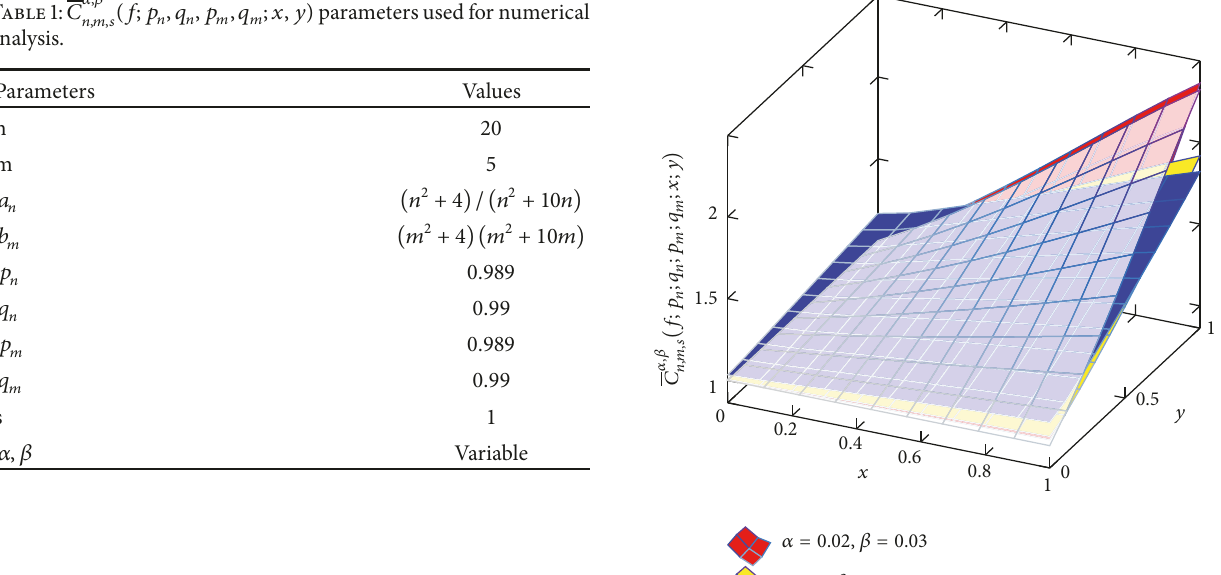
𝛼,𝛽 (𝑓;𝑝 , 𝑞 ,𝑝 ,𝑞 ;𝑥, 𝑦) parameters used for numerical 𝑛 𝑛 𝑚 𝑚 𝑛,𝑚,𝑠